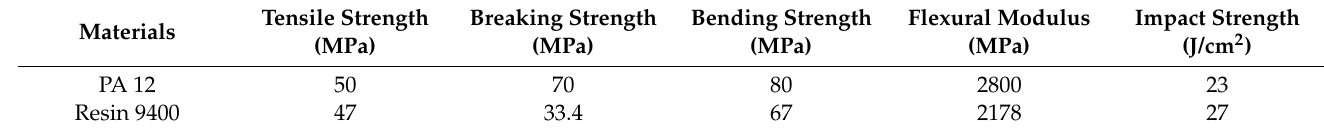
Table 3. Material parameters of PA 12 and Resin 9400.